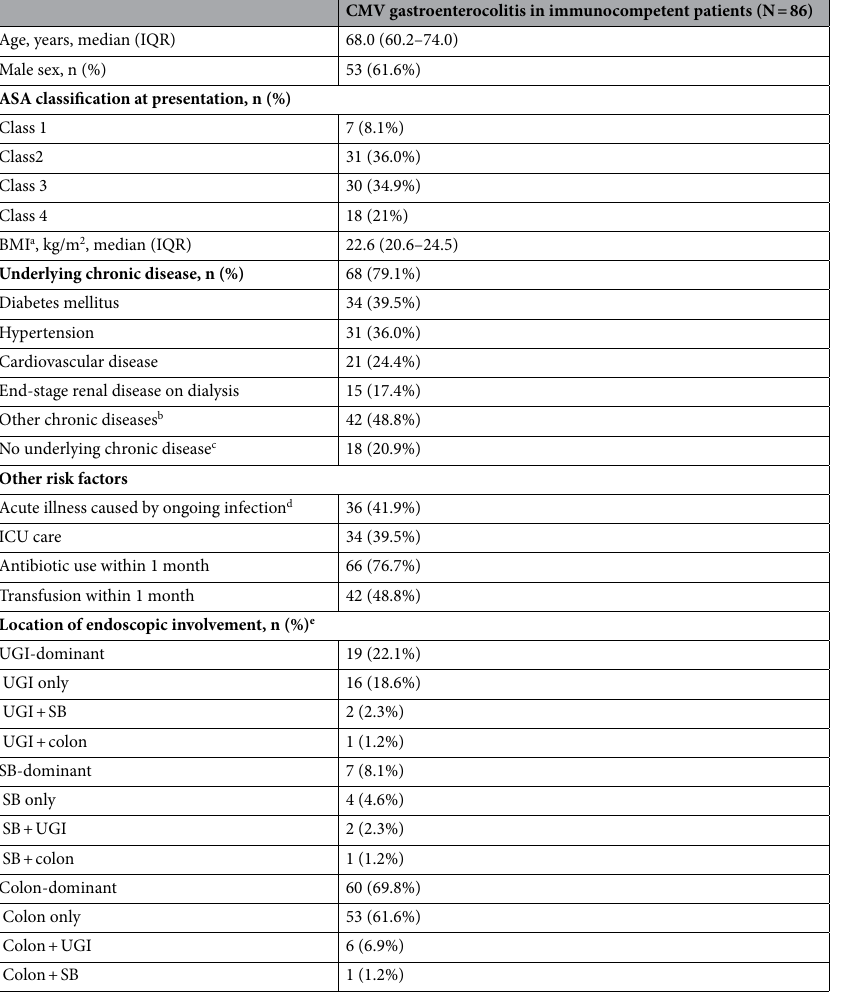
Table 1. Baseline characteristics of immunocompetent patients with cytomegalovirus gastroenterocolitis. CMV, cytomegalovirus; IQR, interquartile range; ASA, American Society of Anesthesiologists; BMI, body mass index; ICU, intensive care unit; SD, standard deviation; UGI, upper gastrointestinal (esophagus and stomach); SB, small bowel (duodenum, jejunum, and ileum). a BMI data were not available for 2 of the 86 patients. b Other chronic diseases included chronic kidney disease, chronic liver disease, neurologic disease, and rheumatologic disease. c These 18 patients did not have both underlying chronic diseases and ongoing acute illnesses, such as infection. d Ongoing infection included pneumonia, urinary tract infection, diabetes mellitus foot, liver abscess, sepsis, infective endocarditis, intraabdominal abscess, and muscle abscess. e The total number of involved segments was